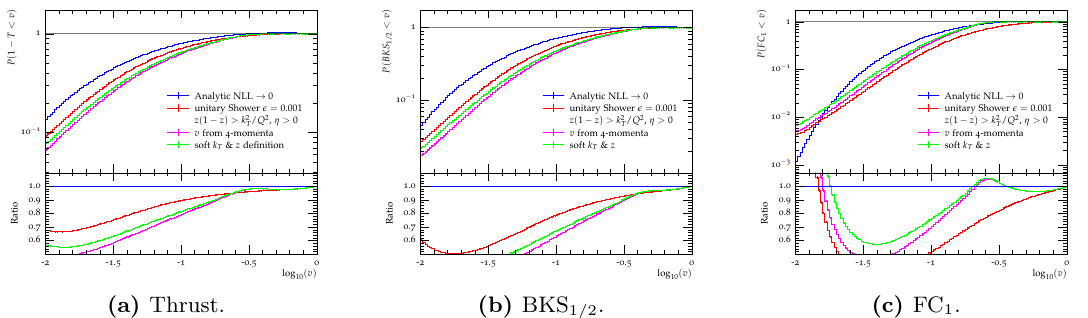
Figure 6 . Comparison of pure NLL resummation and plain DGLAP parton shower, e(cid:11)ects of approximating the observable compared to exact calculation using four-momenta and evolution in dipole- k T